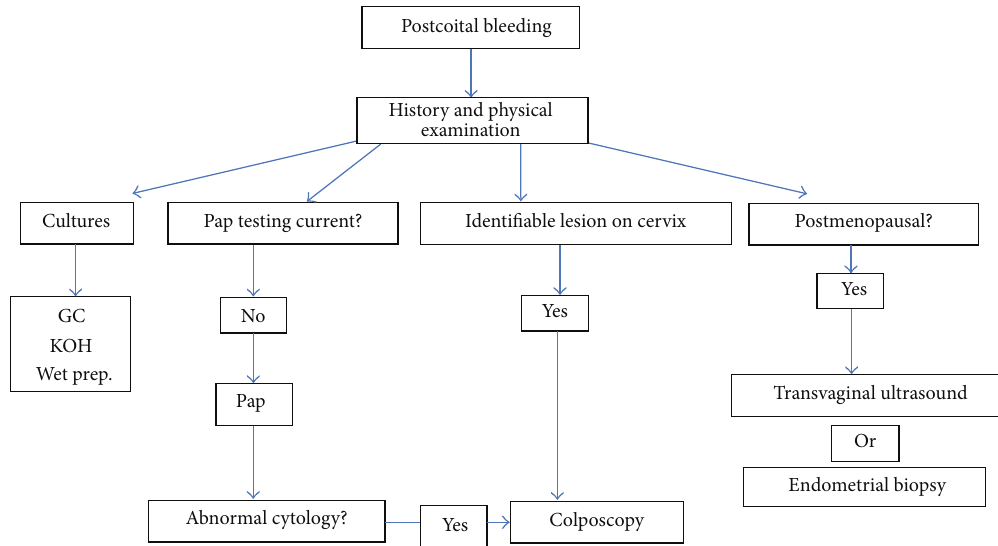
Figure 1: Diagnostic approach to postcoital